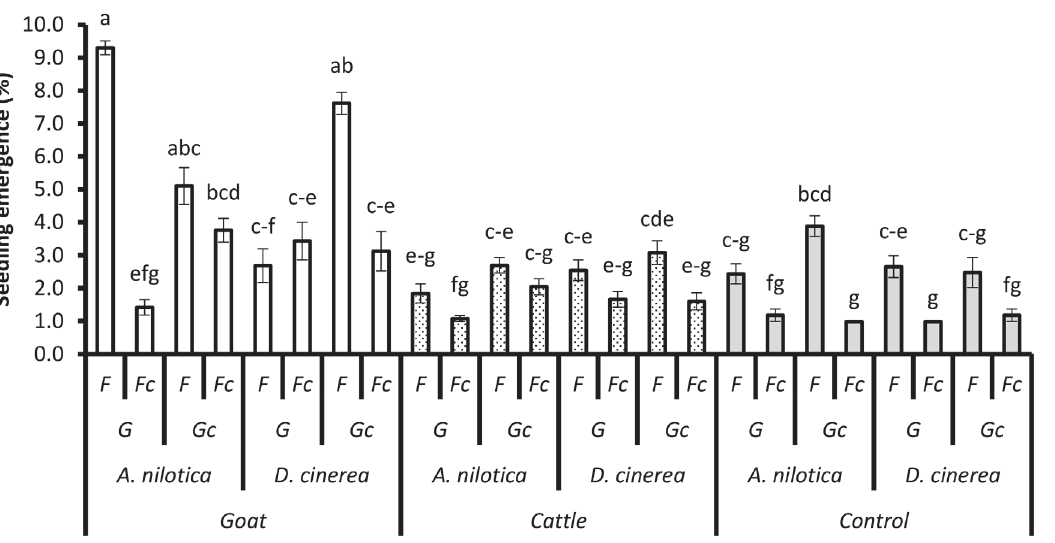
Fig 4. The treatment combination effects of animal species (goats, cattle), unpassed/untreated seeds (i.e. not ingested), seed species ( A . nilotica , D . cinerea ), grass (G) (and mowed grass (Gc)), fire (F) (and no fire (Fc)) on seedling emergence during the dry season. Bars represent standard errors (S.E). Same letters on the bars mean that P > 0.05. A LSD post hoc test was